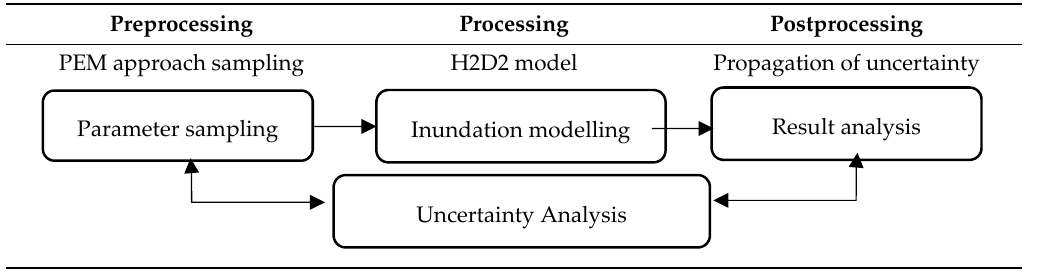
Table 1. General procedure for uncertainty analysis based on point estimate method (PEM)